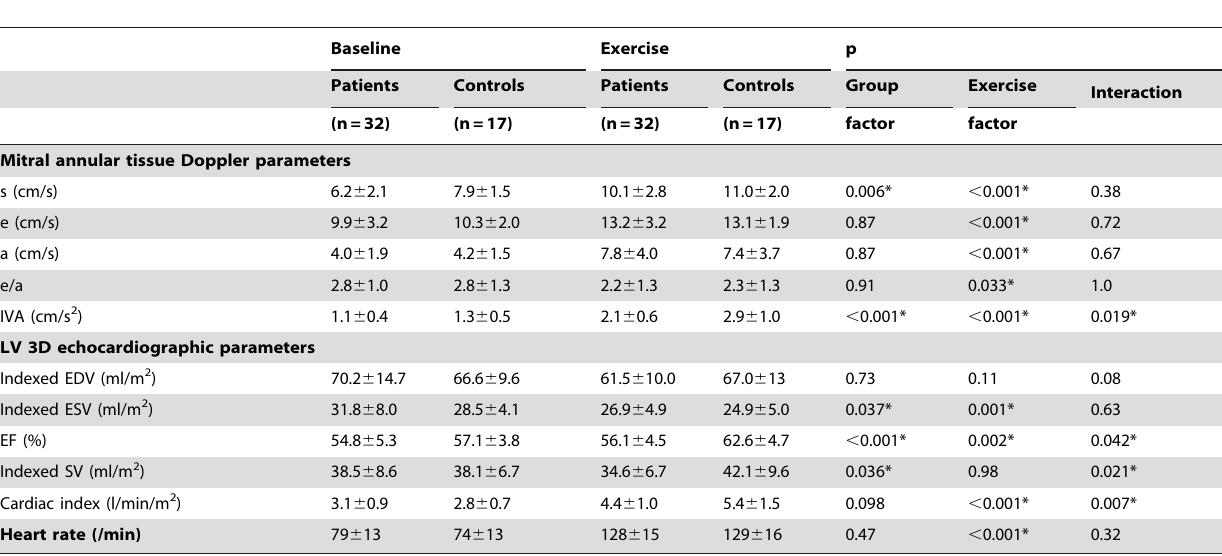
Table 2. Comparisons of echocardiographic parameters between patients and controls at baseline and during supine bicycle exercise.